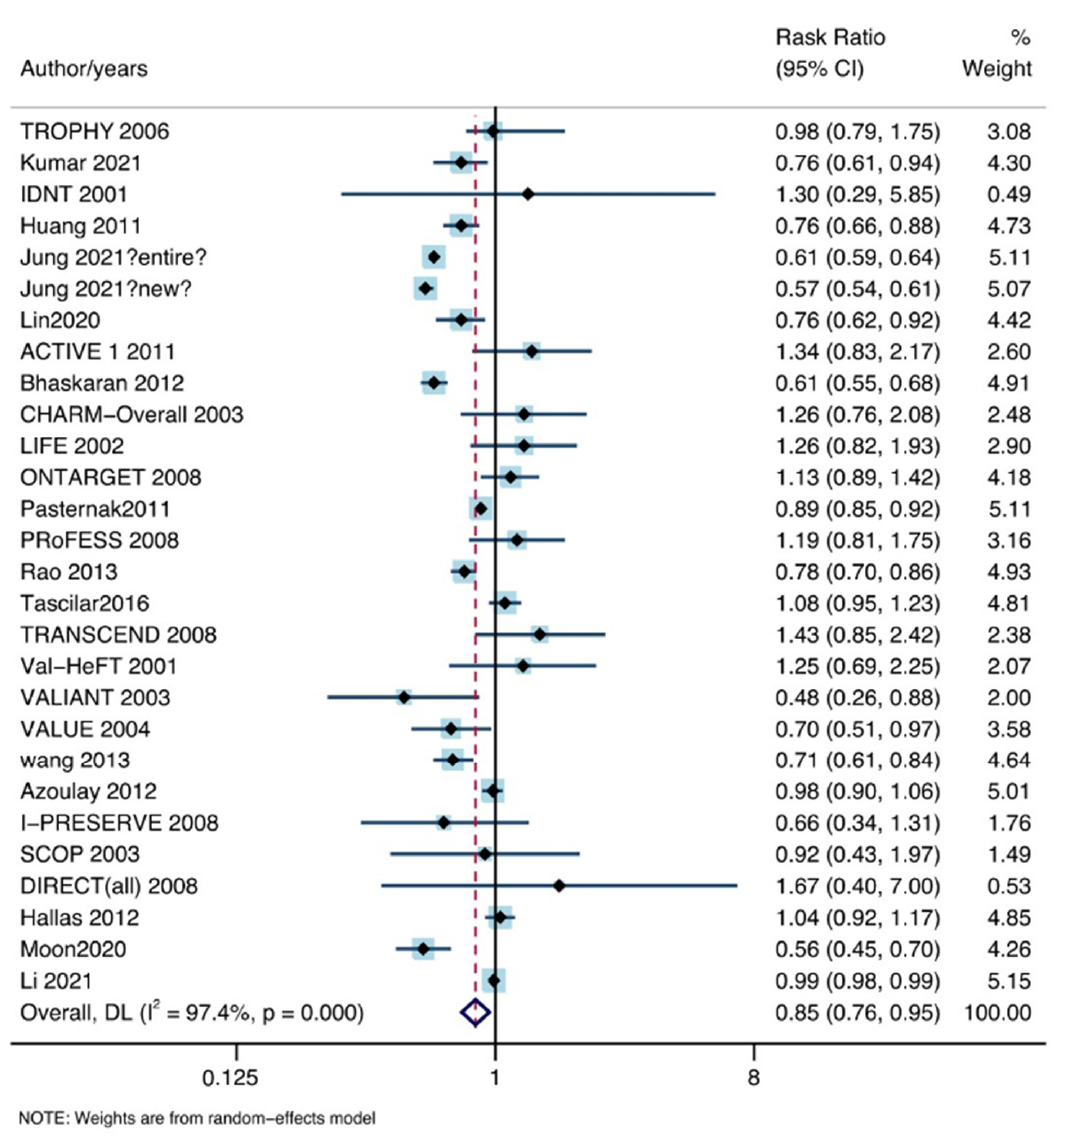
Figure 3. The association between ARB drugs and incidence of lung cancer.